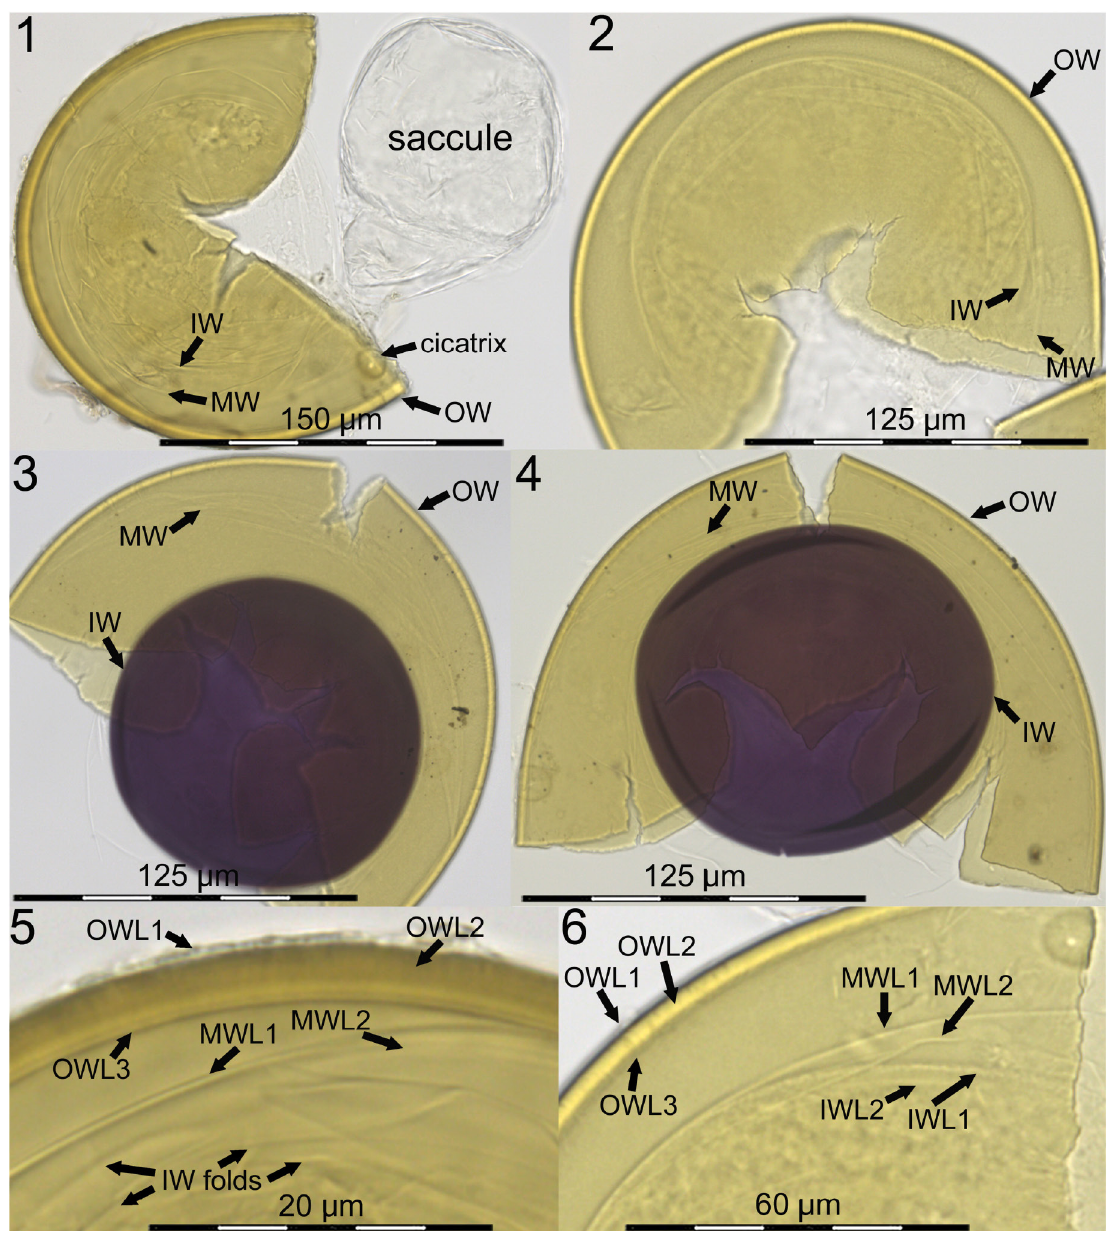
Figs. 1-6: Acaulospora flavopapillosa. 1-2. Crushed spores in PVLG with three walls (OW, MW & IW) formed laterally on the neck of sporiferous saccules, and forming a single permanent cicatrice on the outer wall. 3-4 . Crushed spores in PVLG + Melzer’s. 5. Papillate spore surface in cross view: Papillae are approximately 1 μm wide and high. OWL1 hyaline and evanescent to semi-persistent. OWL2 permanent, structural and brownish yellow to yellow- brown, OWL3 ususally closely adherent to OWL2. MWL1-2 hyaline and often not easily separated by pressure on the cover slide, or when separate, often each showing several wrinkling folds due to their high flexibility (e.g. Fig. 3). 6. IWL1 generally only 0.8-1.1 μm thin, and thus, its beaded ornamentation is only observed, when clearly separating from IWL2. IWL2 stains purple to dark purple in Melzer’s (Figs. 3-4). IWL3 difficult to ob - serve as only 0.5-1.1 μm thick and usually closely adherent to